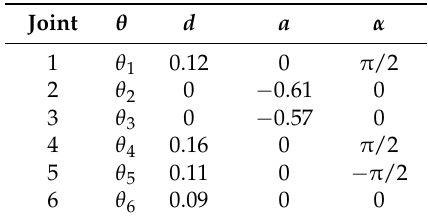
Table 1. D-H parameters for UR10